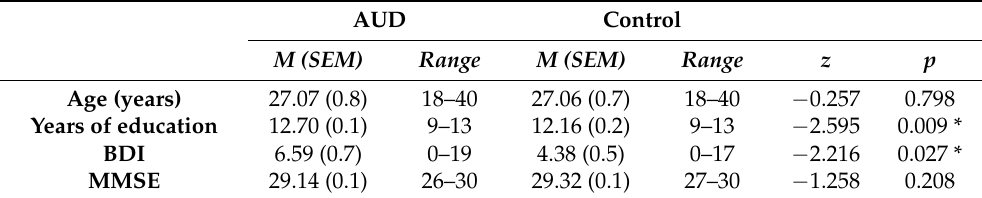
Table 1. Sociodemographic measures for AUD and control